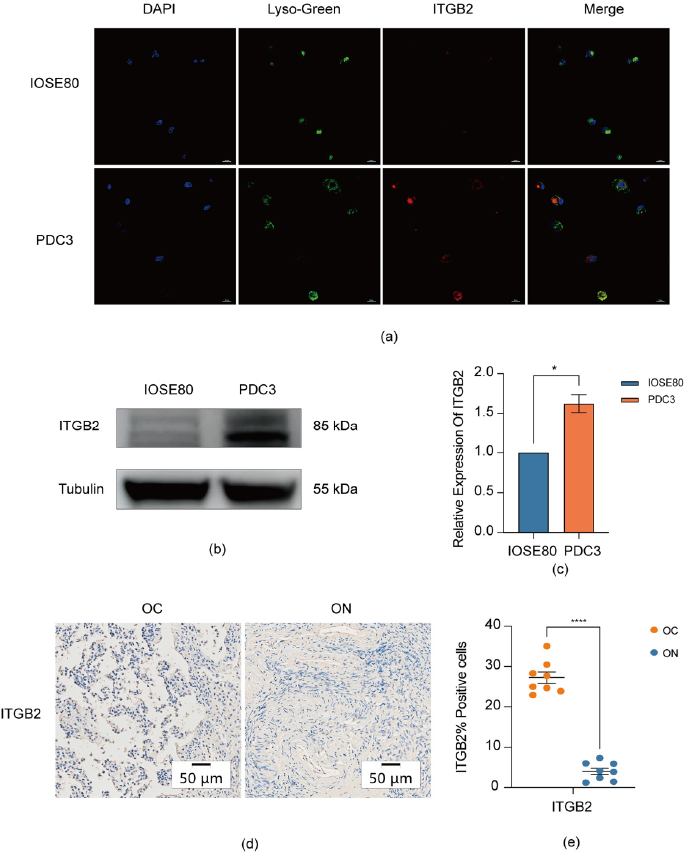
Figure 5. Validation of the expression of ITGB2 in PDC and specimens. ( a ) Location of ITGB2 in two ovarian cancer patient-derived cells via confocal microscopy (red: ITGB2; blue: cell nucleus; green: cell lysosome; scale bar = 20 µm); ( b ) Expression of ITGB2 in IOSE80 and PDC3 cells by Western blotting; ( c ) Detection the relative mRNA expression of ITGB2 via qPCR (* p < 0.05); ( d ) Representative immunohistochemical staining of ITGB2 in serous ovarian cancer tissues and control tissues. (OC: ovarian cancer; ON: matched control ovarian tissues); ( e ) Quantification of ITGB2-positive cells in tumor tissues (**** p < 0.0001, two-tailed, unpaired Student’s t test). At least two independent experiments were performed, and the data in the figure are shown as means ±